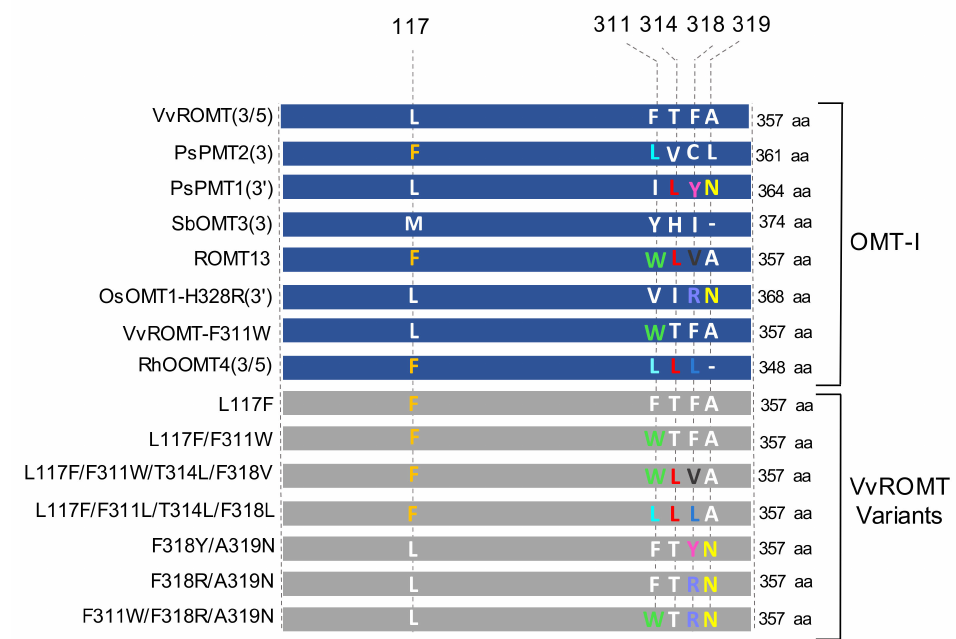
Figure 4. Schematic design of the VvROMT variants. For the construction of VvROMT variants (grey) we selected two regions that interact with resveratrol according to our VvROMT substrate-binding site model. The residue substitution is color-coded and is related to the type-I OMTs (blue) included in the analysis; their regioselectivity is indicated in parentheses. As an example, the substitution F311L (cyan) is found in the enzymes PsPMT2 and RhOOMT4, while the substitution F311W (green) is found in the enzyme ROMT13 [46] and the previously reported variant F311W